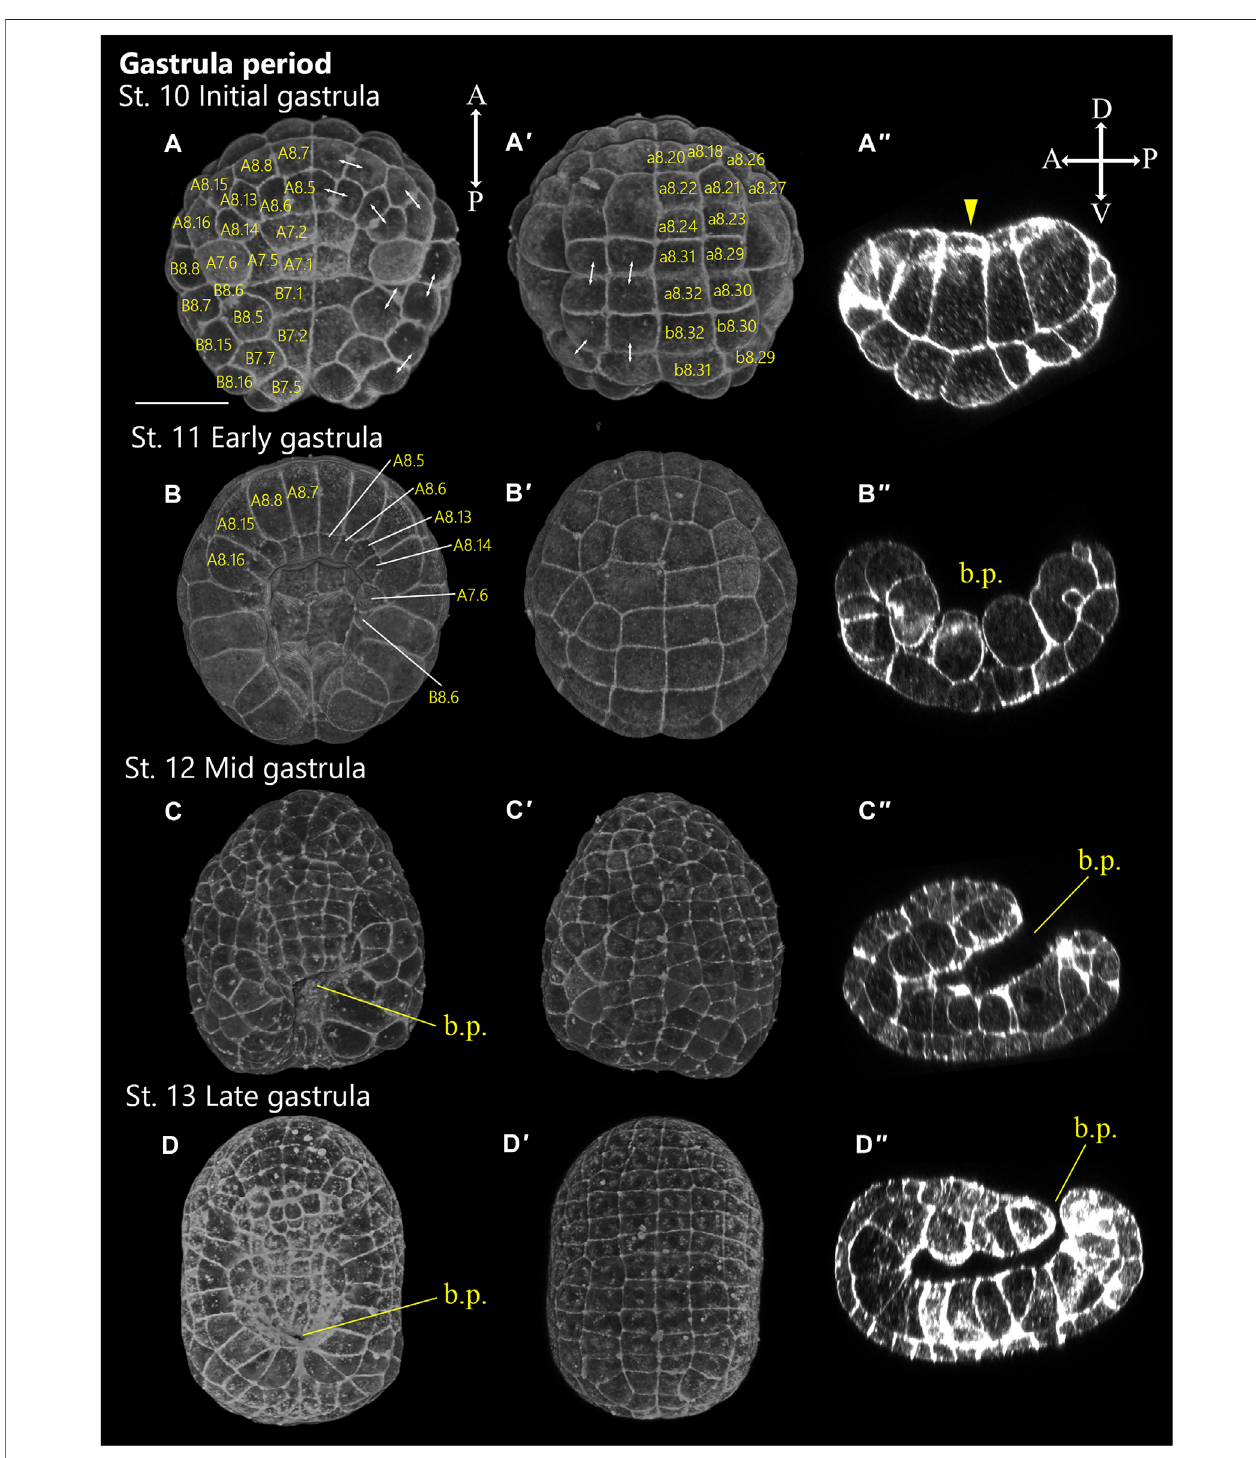
FIGURE 4 | Ascidiella aspersa embryos at gastrula period. Embryos are stained with Alexa Fluor ™ 546 Phalloidin. Three-dimensional reconstructed images at (A,A 9 ) Stage 10 (110 cell, initial gastrula), (B,B 9 ) Stage 11 (early gastrula), (C,C 9 ) Stage 12 (mid gastrula), (D,D 9 ) Stage 13 (late gastrula). (A – D) show the dorsal views of the embryos, and (A 9 – D 9 ) show the ventral views of the embryos. (A 99 – D 99 ) Longitudinal sections of (A – D) , respectively. Anterior side of each embryo is up in (A – D, A 9 – D 9 ) .In (A 99 – D 99 ) ,embryodirectionisshown byA,anterior,P,posterior, D,dorsal, V,ventral. Two-headedarrows indicatethepairofdaughtercells.Thenumber of cell-lineages are drawn on each blastomere. b.p., blastopore. Scale bar: 50 μ m.